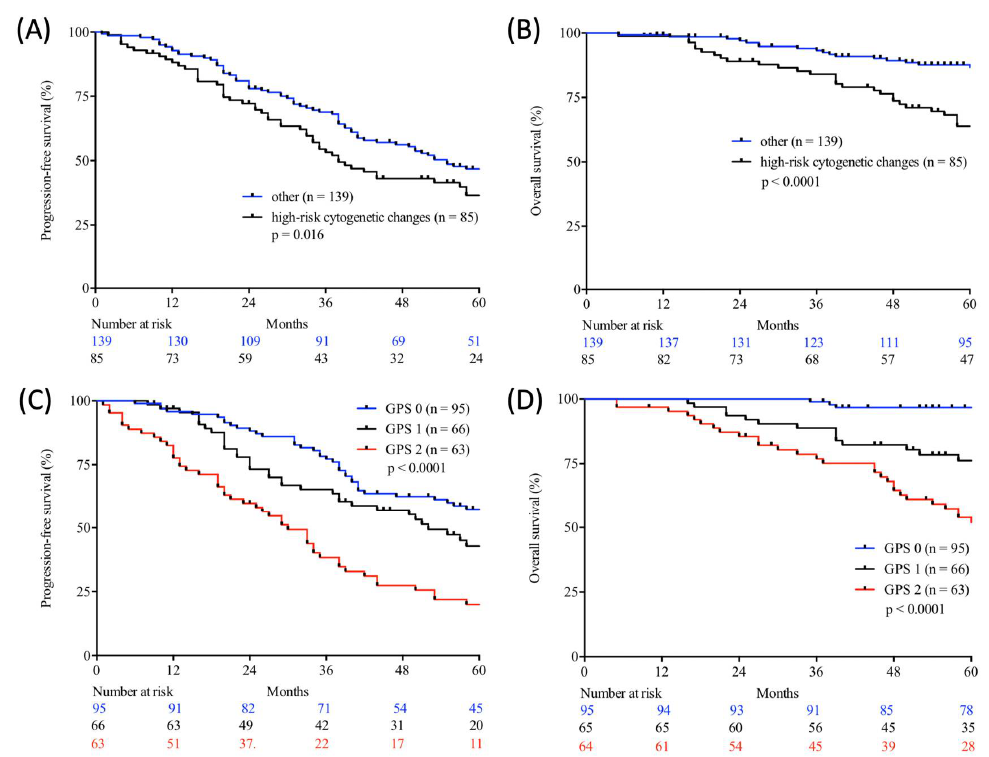
Figure 2. Progression-free ( A , C ) and overall ( B , D ) survival according to cytogenetic changes (log-rank test; high-risk cytogenetic changes vs. other; A, B) and Glasgow Prognostic Score (GPS) (log-rank test; GPS 0 vs. GPS 1 vs. GPS 2; C, D) in autologous stem cell transplanted (ASCT) patients with multiple